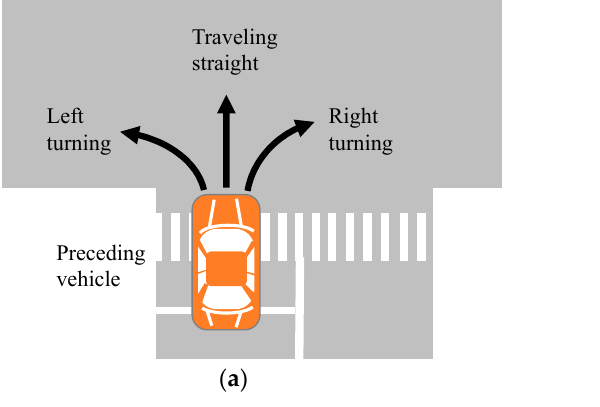
Figure 4. Traveling directions of other vehicles: ( a ) preceding and ( b ) oncoming vehicle.